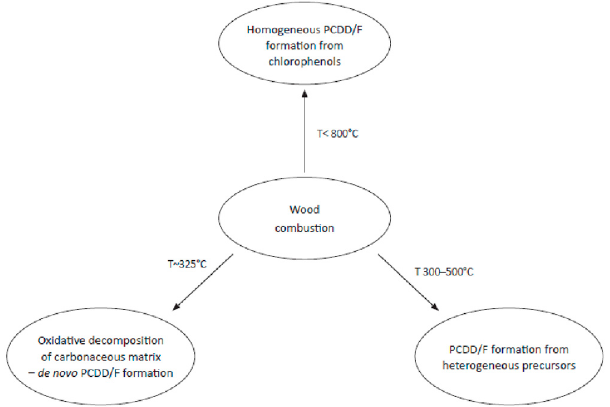
Figure 2. The effect of combustion temperature on PCDD/F formation. Figure 2. The e ff ect of combustion temperature on PCDD / F